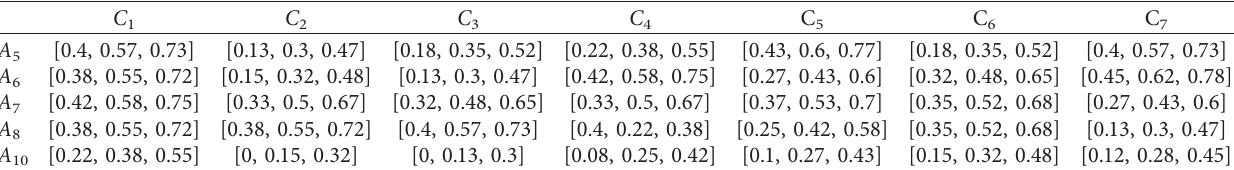
Table 7: The fuzzy decision matrix in the uncertainty region.